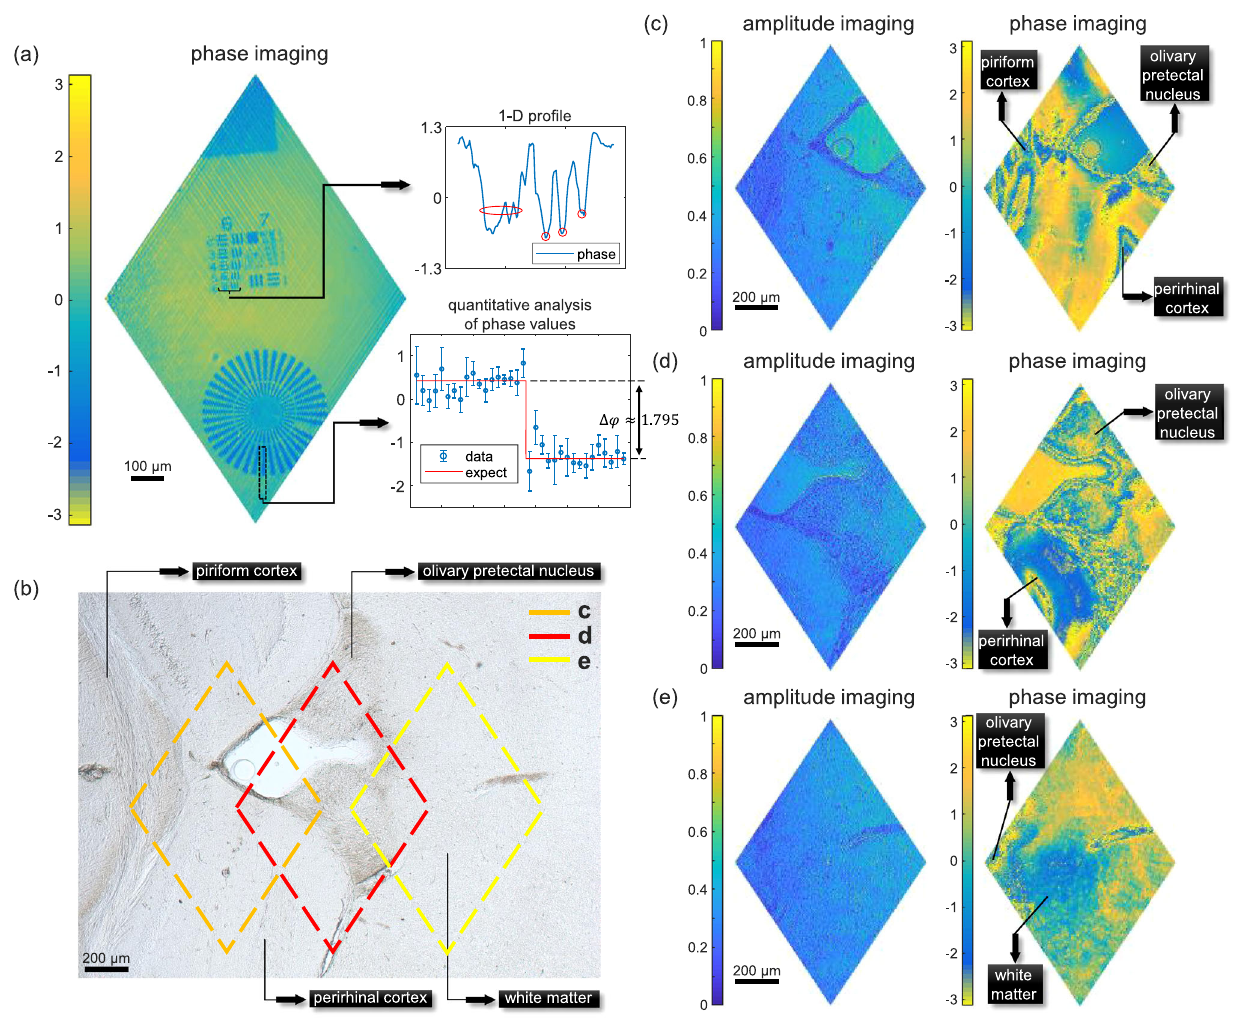
Fig. 4 Performance of the high-throughput SPH with unstained tissue from mouse brains in high-resolution mode. a Reconstructed phase image of a quantitative phase target. The upper inset: the corresponding 1D pro fi le of element 6 of group 6; the lower inset: quantitative analysis on the accuracy of the reconstructed phase values (actual phase difference 4 φ ¼ 1 : 795 rads). The data are presented as mean values and standard deviations, resulting in a phase error of about 0.104 rads (from n = 4 independent measurements). b The image of a slice of unstained tissue from mouse brains, captured using a conventional microscope. Three diamond-shaped boxes represent the area being imaged by the holographic system. c – e The reconstructed amplitude and phase images for different parts of the unstained tissue. The corresponding scale bar is 200 μ